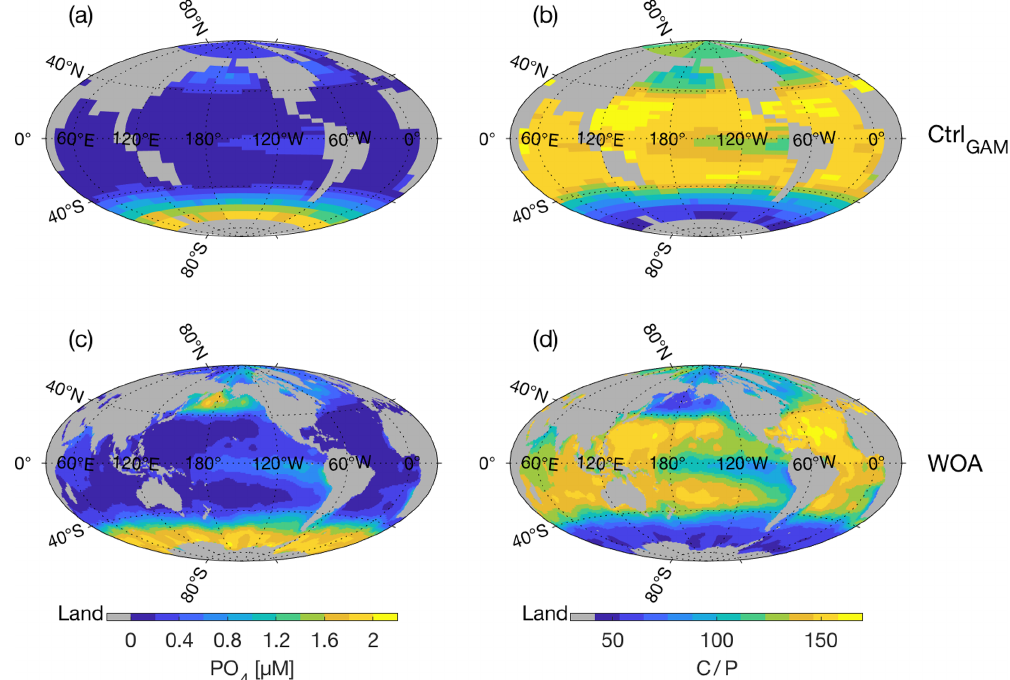
Figure 3. Surface PO 4 concentration (µM) (a, c) and corresponding C / P as calculated using parametrization of Galbraith and Martiny (2015) (b, d) . Panels show Ctrl GAM (a, b) and climatological mean fields (World Ocean Atlas 2018, Garcia et al., 2018b) (c, d)